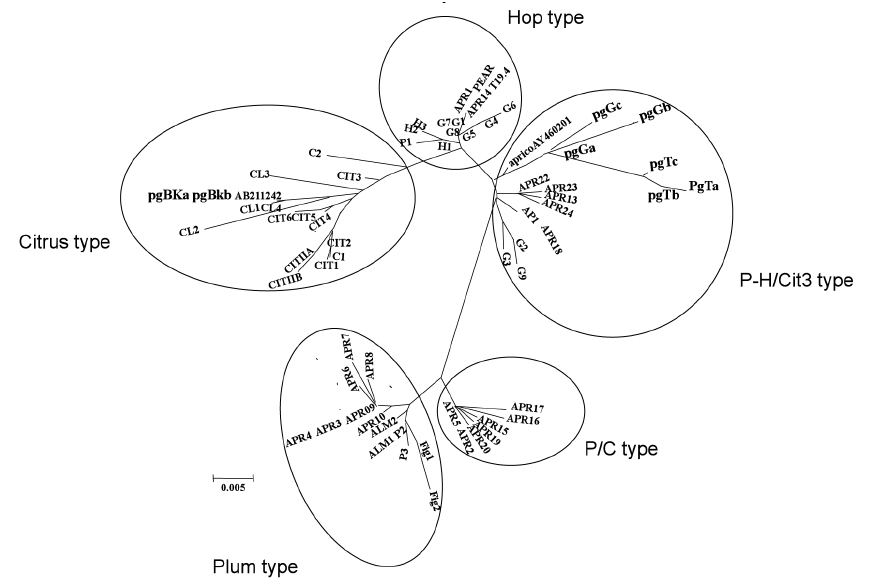
Figure 3. Neighbor-joining tree of Hop stunt viroid (HSVd) sequence variants from published sequences. Variant sequences determined in this work are indicated in bold type. The five phylogenetic groups identified previously by Kovalfi et al., (1997) are